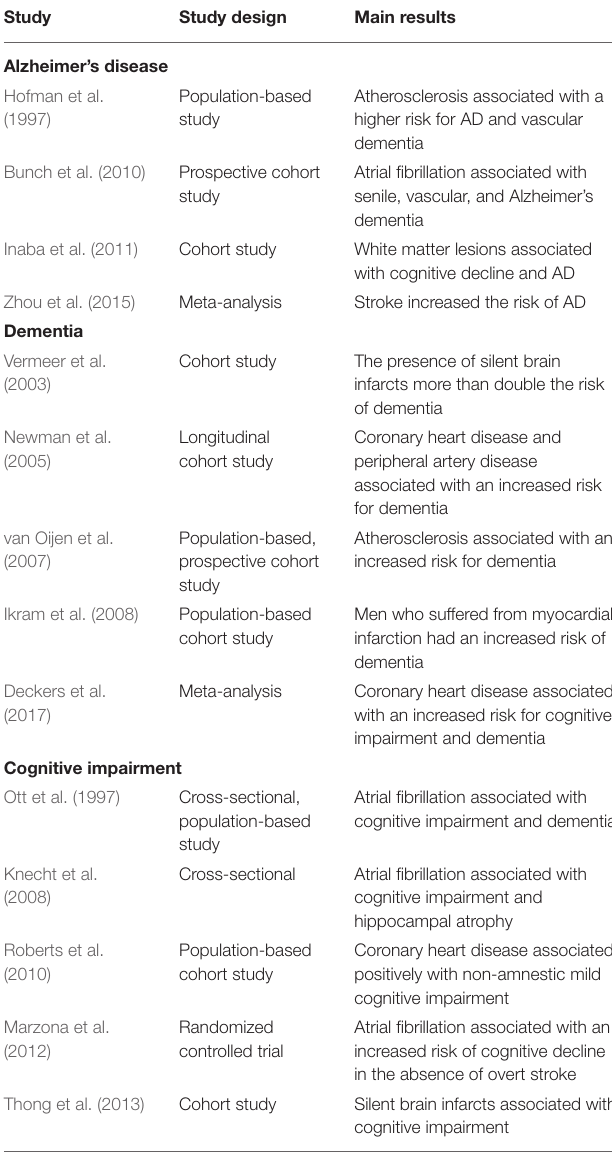
TABLE 2 | Studies investigating the association between cardiovascular risk factors, dementia and AD. Study